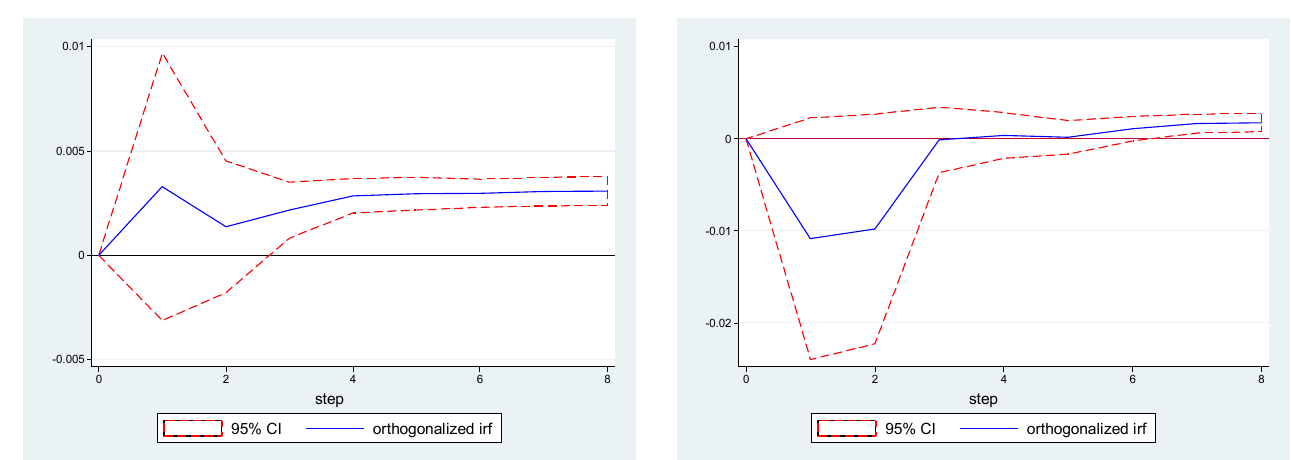
Figure 2. Impulse Response Function of Expect to lnCurrency and Shortcapital. Figure 3 reports the impulse response of RMB internationalization to RMB exchange rate expectation shock and short-term capital flow shock. As can be seen from the left panel of Figure 3, the response of RMB internationalization to RMB exchange rate expectation shock is positive with an increasing trend over the horizons. The shock impact peaks at around 0.012 percentage points in the second horizon and is persistent at this level throughout the rest of the horizons. The results confirm that RMB appreciation expectation has a significant positive effect on RMB internationalization. The right panel of Figure 3 shows that, given a positive shock of short-term capital flow, offshore market RMB deposit responds positively, rising up to 0.04 percentage points in the fourth horizon and continuing to rise thereafter. Thus, short-term capital inflow could promote RMB internationalization and the positive shock impact is persistent.